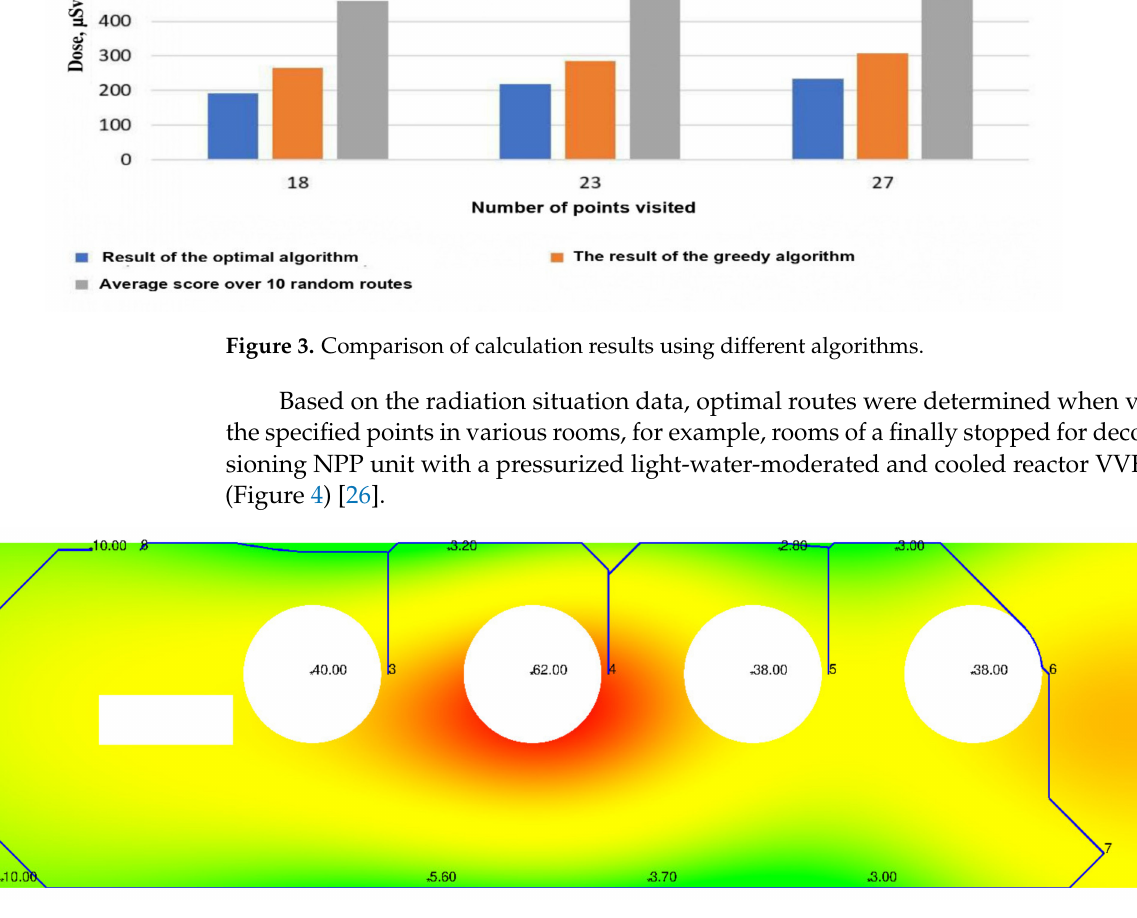
Figure 4. Optimal movement route to visit the specified points in the room of the primary circuit volume compensator (14.6 × 3.8